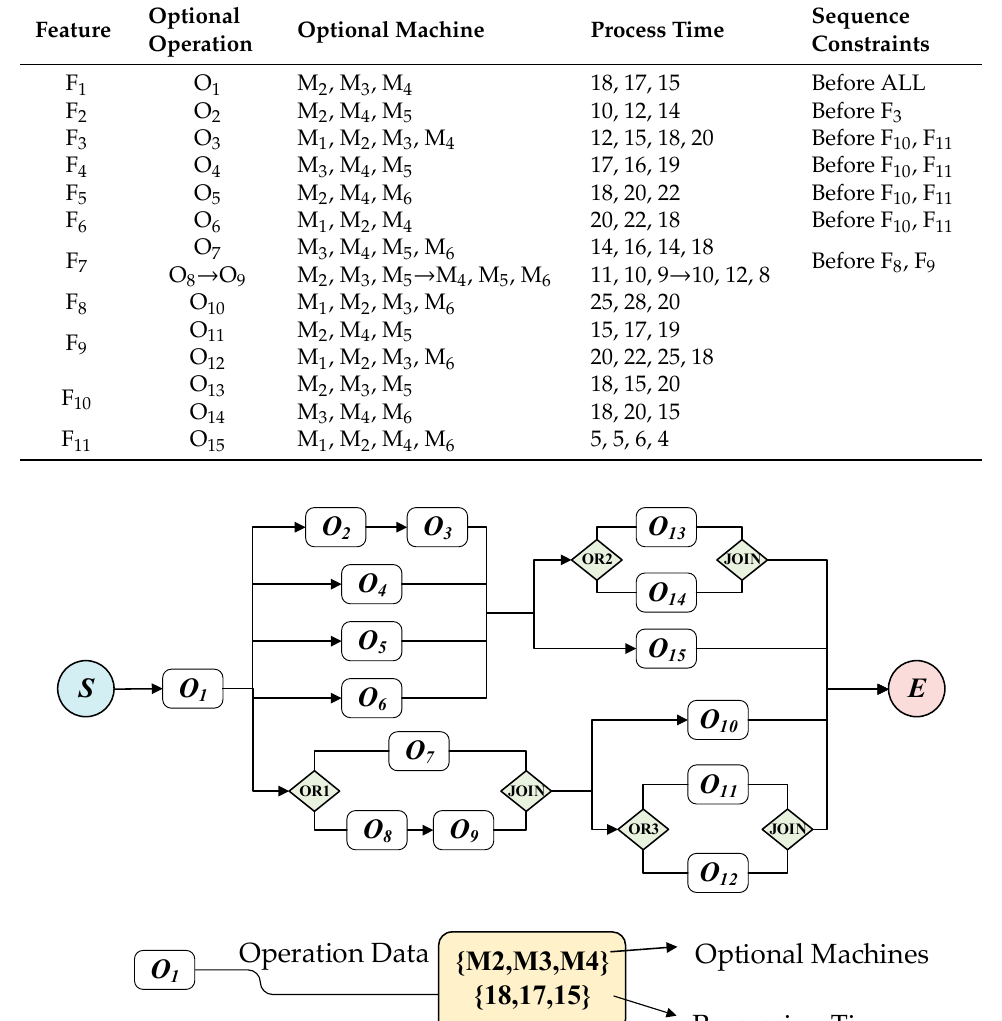
Table 1. An example of a product process information.